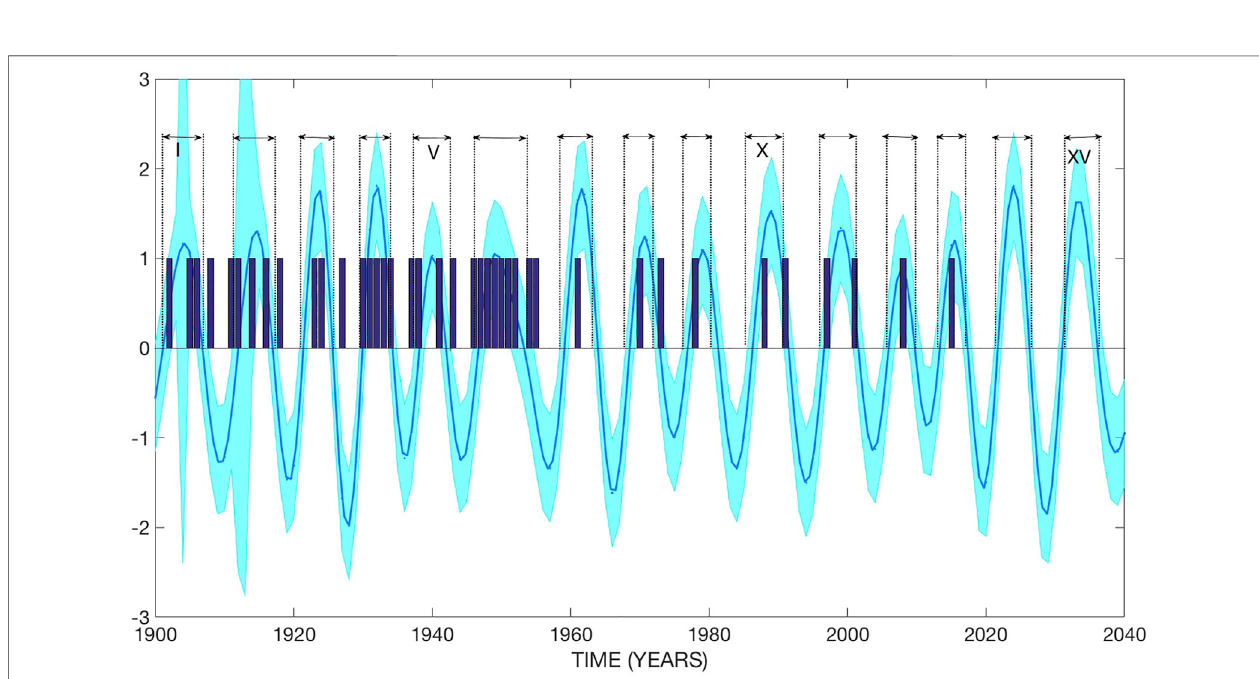
FIGURE14| Probabilisticearthquakeprediction forSouthern China-Northern India.Bayesianinference ofLS-SVMmodel(bluelineandshade) comparedwiththe historical Southern China-Northern India earthquakes clustered in thirteen groups (I-XIII) and shown with vertical blue bars from 1900 to 2021. In addition, the probabilistic earthquake prediction is shown for the following two period (clusters XXIV and XV). The blue shaded area represents the 95% con fi dence intervals of the Bayesian model.